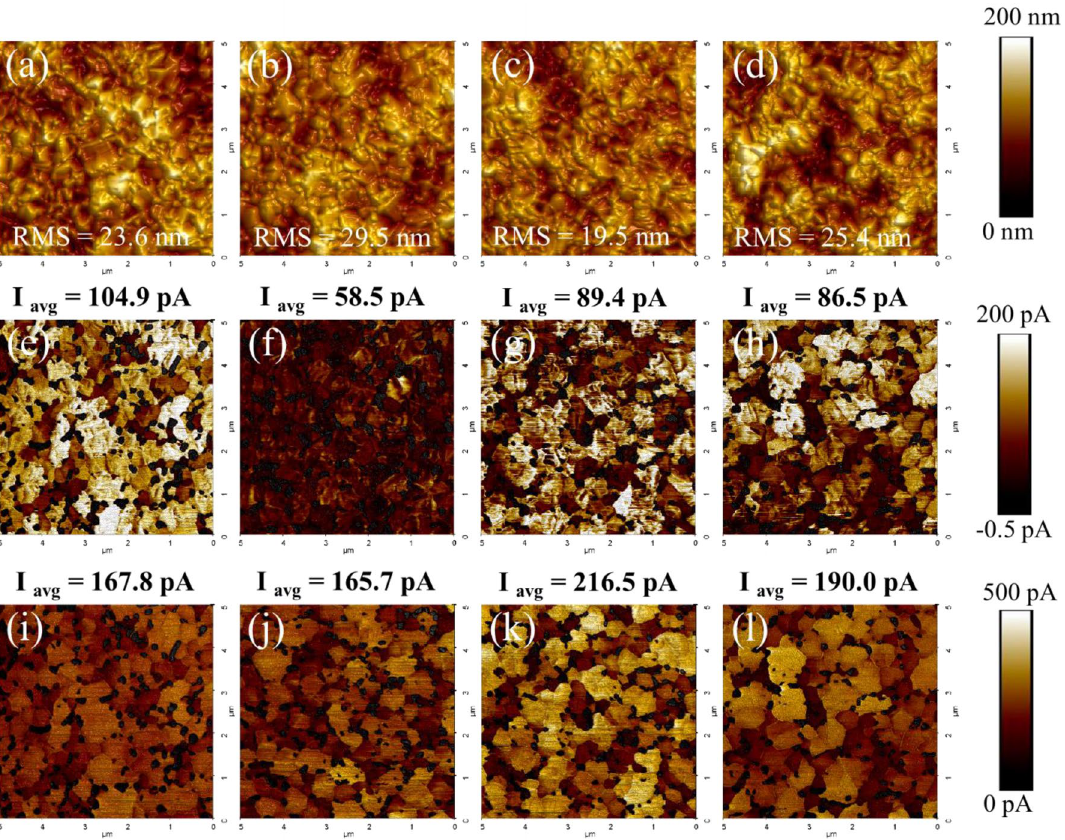
Figure 5. AFM topographic images and corresponding photocurrent distributions by C-AFM for different perovskite films. ( a – d ) Topography images for RT, 60 °C, UV, and 1-Sun samples. ( e – h ) The open-circuit voltage (V oc ) mapping for RT, 60 °C, UV, and 1-Sun samples. ( i – l ) The short-circuit current (I sc ) mapping for RT, 60 °C, UV, and 1-Sun